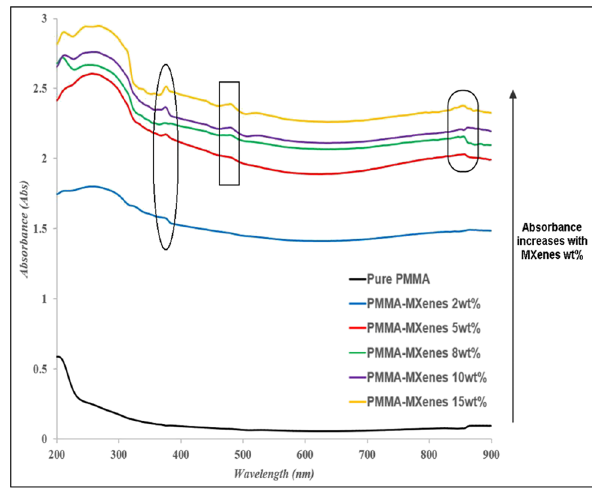
Figure 6: The UV - Vis absorption spectra of all samples as a function of